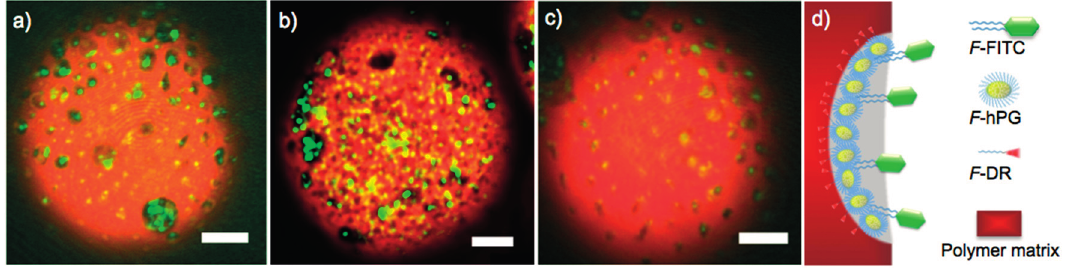
Figure 4. Fluorescence overlay images of bi-fluoro-tagged fluorescein (F-FITC) immobilized on microsphere pore surfaces created by porogens: ( a ) hPG 7.5kDa100 ; ( b ) hPG 13kDa100 ; ( c ) dPG [G3.5] . Scale bar: 10 µm; ( d ) schematic illustration of the immobilization of perfluoro-tagged FITC (F-FITC) by fluorous-fluorous